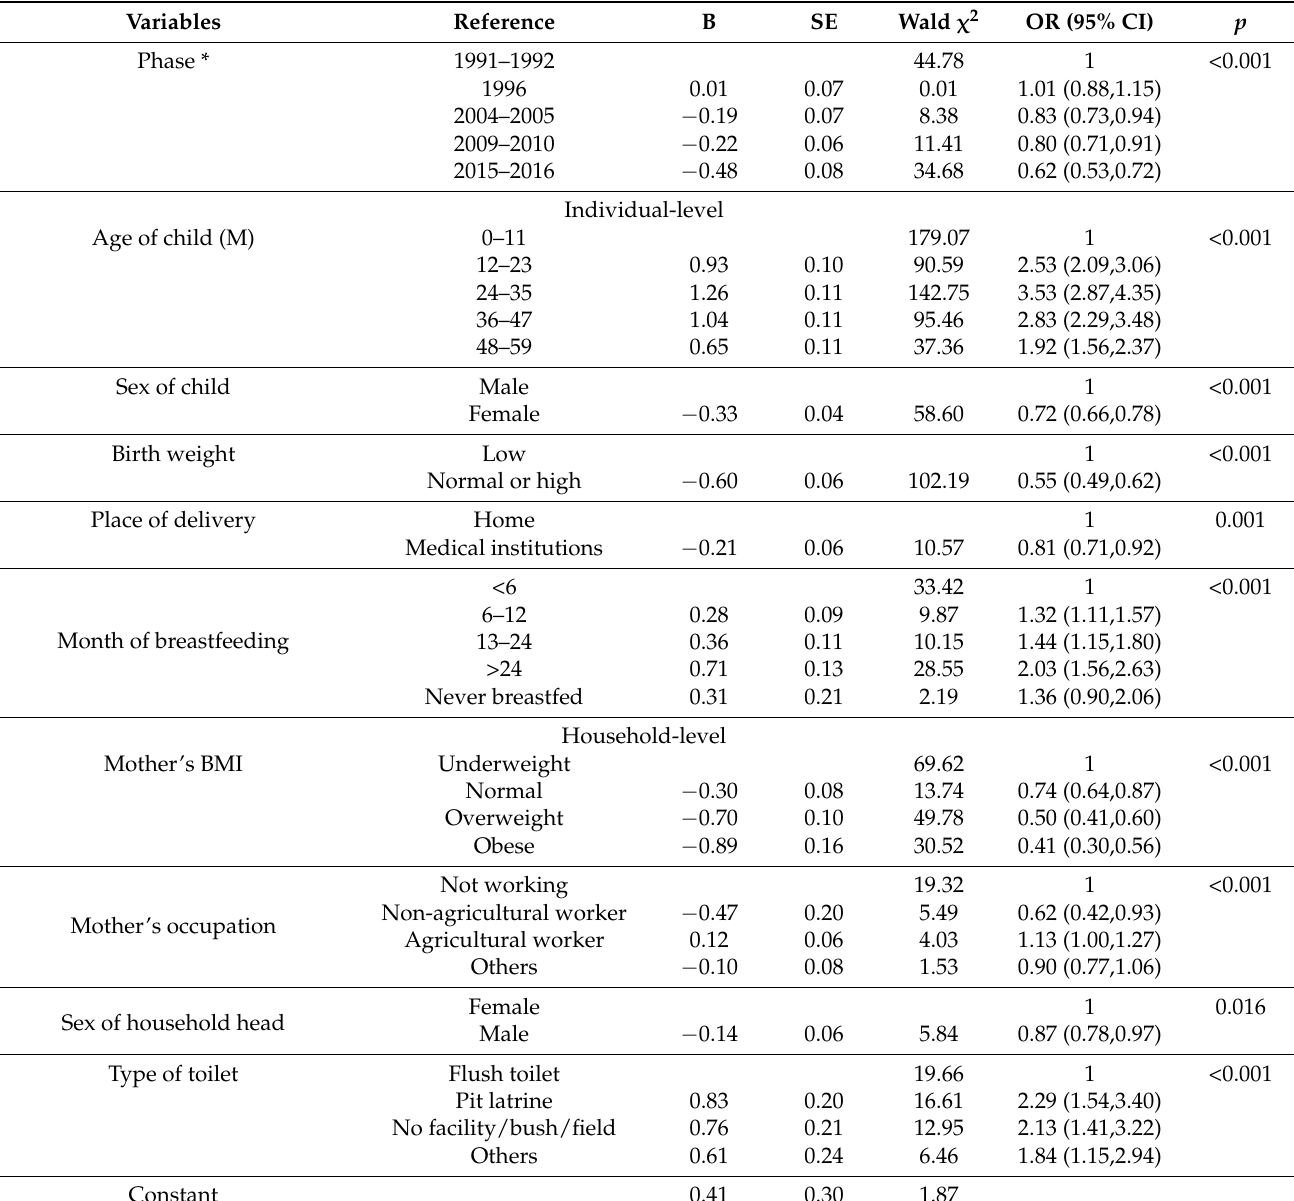
Table 3. The determinants of under-5 child stunting in the rural area based on 1991–2016 Tanzania Demographic and Health Surveys.